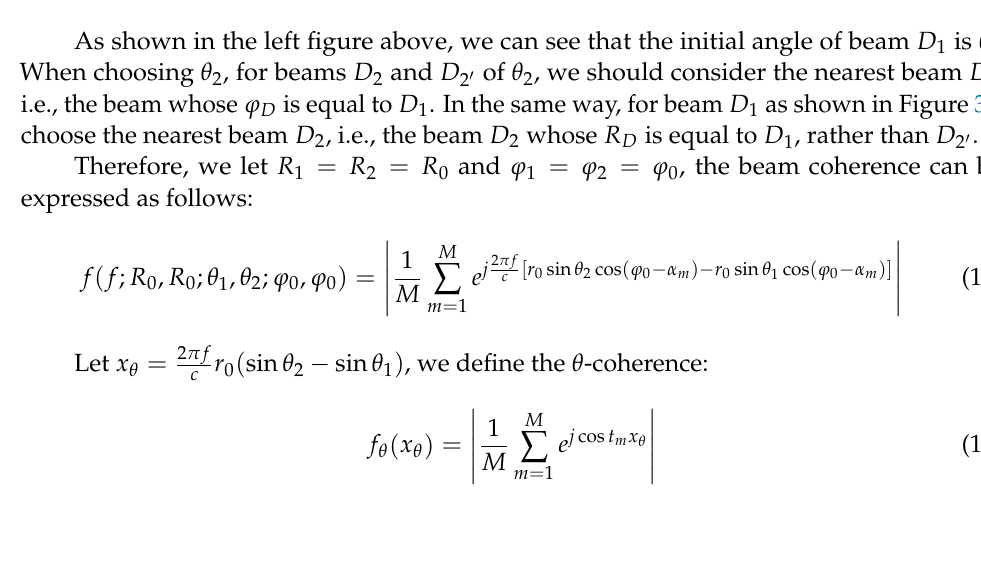
Figure 3. Illustration of beam patterns. ( a ) Beam arrangement in θ − ϕ domain. ( b ) Beam arrangement in R − θ